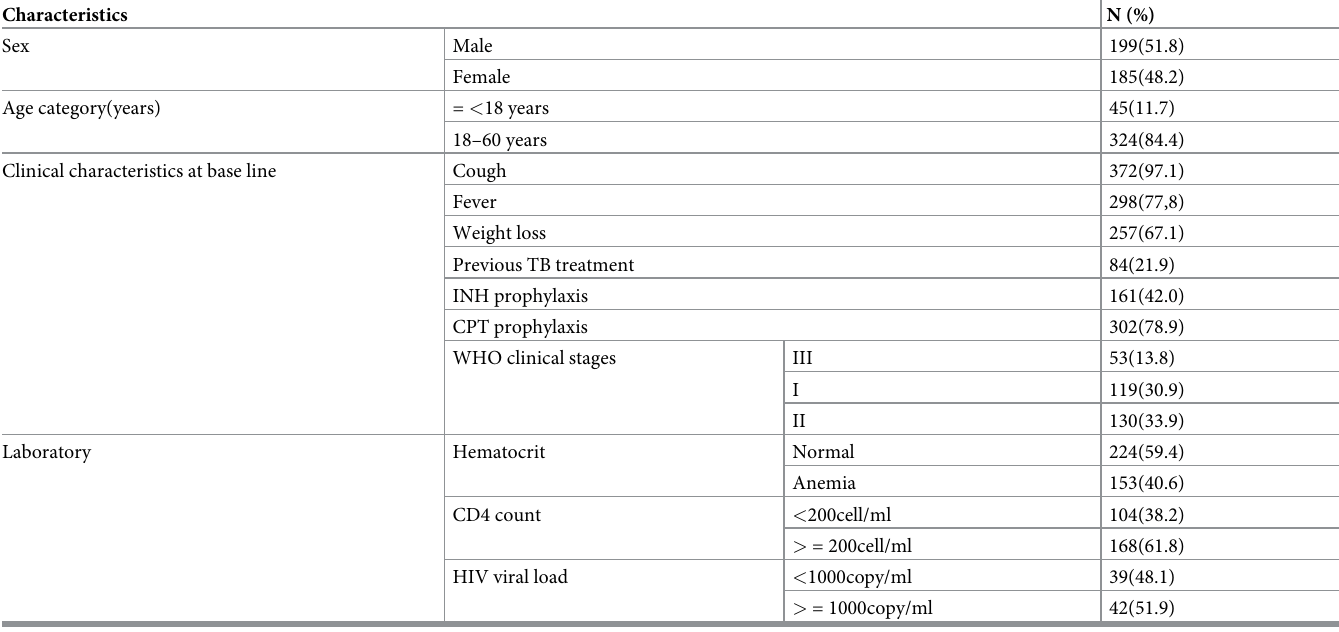
Table 1. Demographic and some clinical data of presumptive TB-HIV co-infection patients among people living with HIV, Asella Teaching and Referral Hospital 2019. (n = 384).